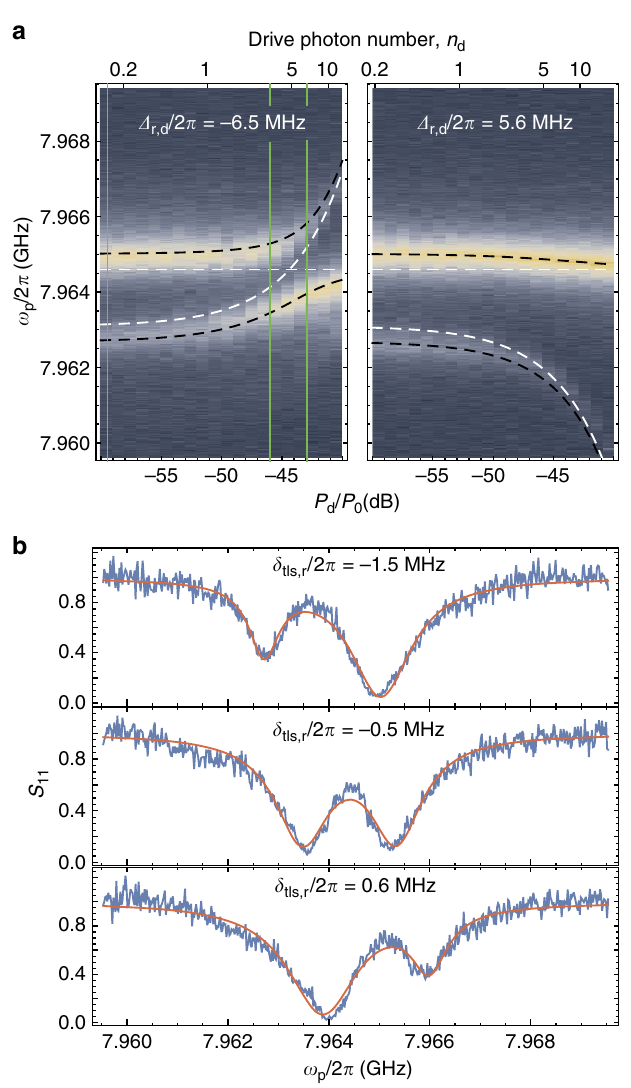
Figure 5 | Two-level system vacuum Rabi mode splitting. ( a ) Colour plot of the measured reflection S 11 of a weak coherent probe tone o p as a function of the drive power P d ( P 0 ¼ 1mW) for drive detunings D r,d /2 p ¼ (cid:3) 6.5MHz (left) and D r,d /2 p ¼ 5.6MHz (right). In these plots, blue (yellow) colour corresponds to high (low) reflectivity. Measurements were taken for a fridge temperature T f ¼ 11mK. The black dashed curve shows the theoretically TLS-resonator frequency tuning for a theoretical model with coherent TLS-resonator coupling g 0,tls /2 p ¼ 0.9MHz and input attenuation A ¼ (cid:3) 66 : 8dB. The white dashed curve is a plot of the same theoretical model including the AC Stark tuning of the TLS but with the resonator and TLS otherwise decoupled. ( b ) Measured spectrum (blue curve) and double Lorentzian fit (red curve) for D r,d /2 p ¼ (cid:3) 6.5MHz and three different drive powers corresponding to the vertical green dashed lines in a . From top to bottom the drive powers are P d / P 0 ¼ (cid:3) 59.5, (cid:3) 46 and (cid:3) 43dB. As indicated, the estimated bare TLS-resonator detuning for each of these drive powers from the fit model is from top to bottom d tls,r /2 p ¼ (cid:3) 1.5, (cid:3) 0.5 and